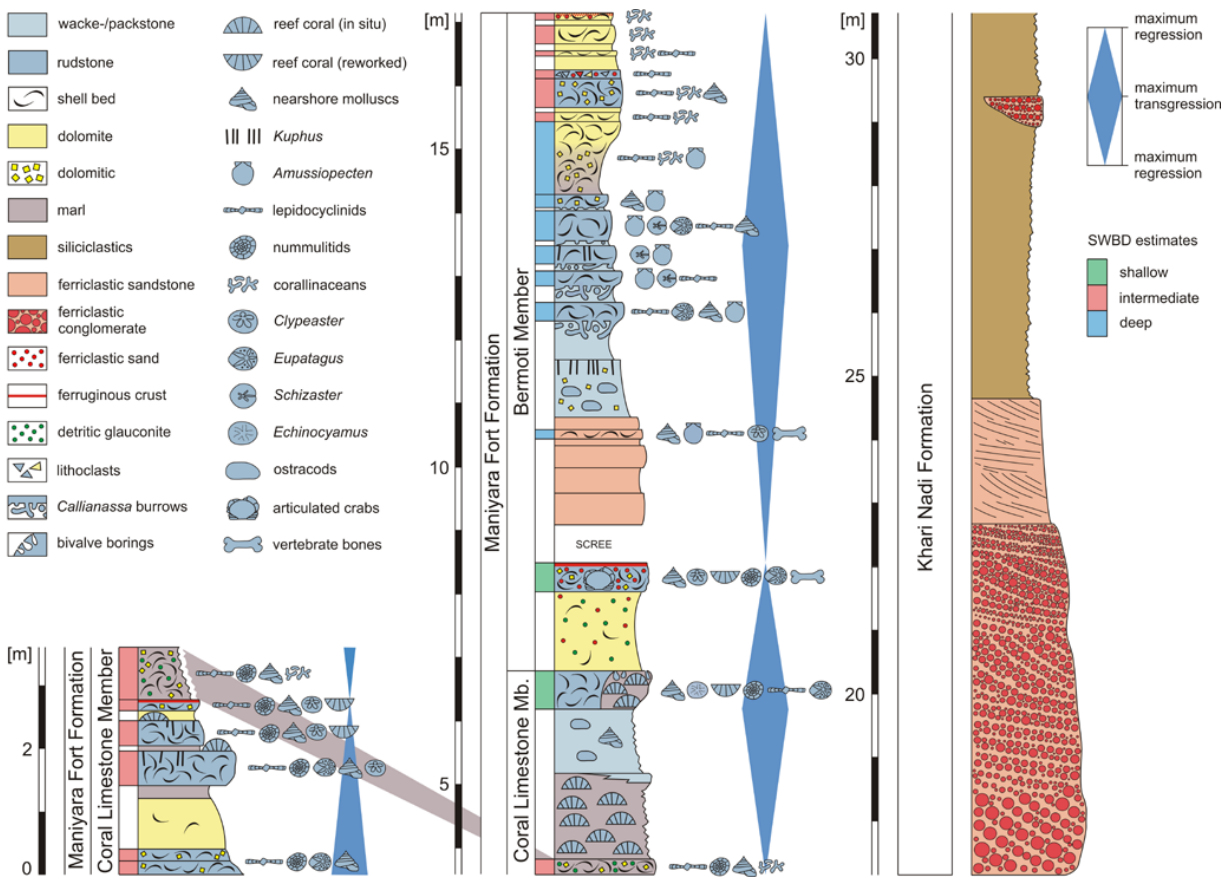
Fig. 2. Bermoti River section. Lithological log, lithostratigraphy (Biswas, 1992), transgressive–regressive cycles and storm wave base depth (SWBD) estimates. The components in the tempestite skeletal assemblages are ordered after their abundance (decreasing from left to right); SWBD estimates refer to Fig.